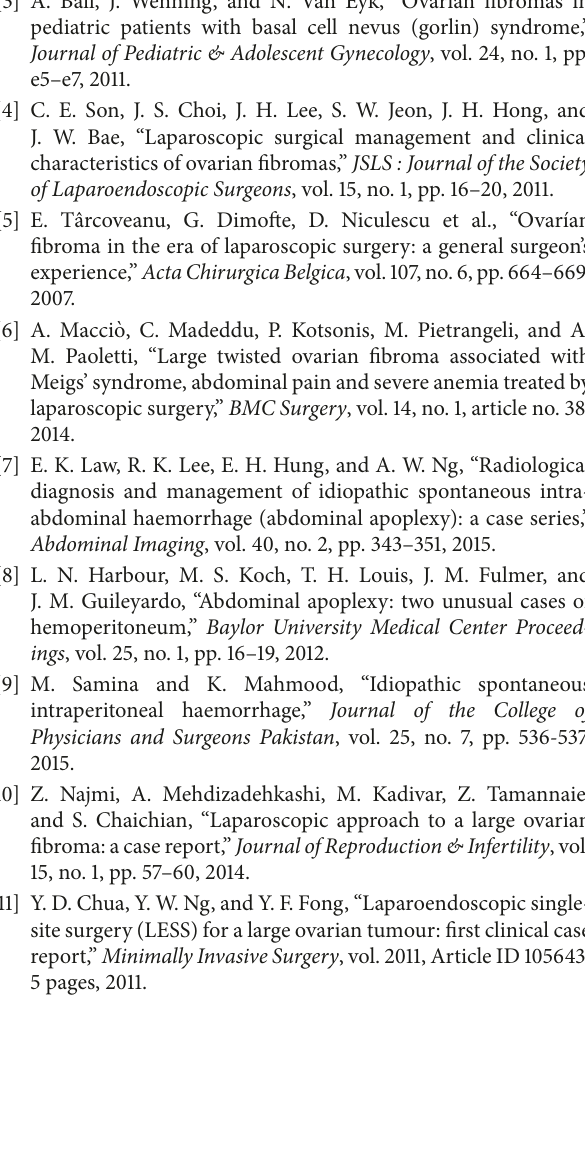
Figure 2: Ovarian fibroma, 48 ounce container. The mass was very hard, and many calcified areas were noted while morcellating.